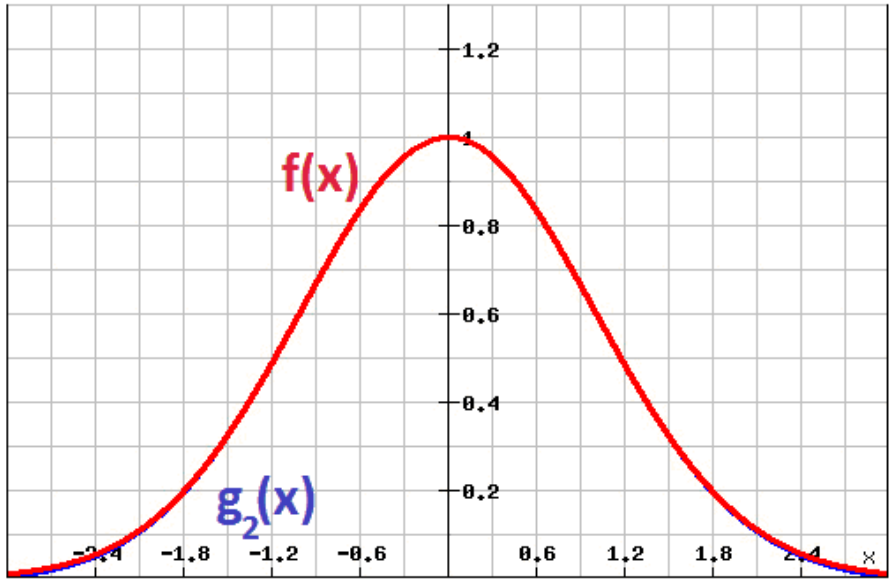
( ) xg ( ) xf functions. 2 and